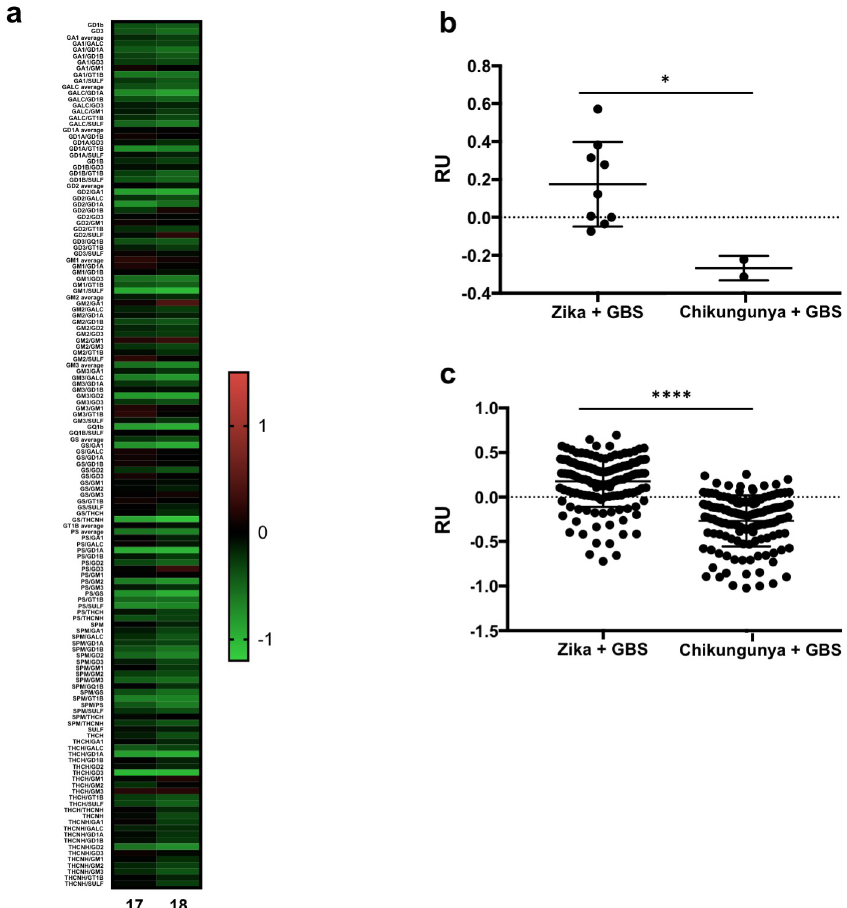
Fig 3. Reactivity of samples from plasma of two GBS patients with active chikungunya virus infection and previous Zika infection (IgG+). ( a ) Heatmap of plasma reactivity to single lipids and lipid combinations. Results from plasma from patients with active chikungunya virus infection (IgM+) and previous Zika infection (IgG+) and GBS compared with Zika infection alone and GBS. ( b ) Average of reactivity values for all lipids and combinations in samples from these patients. ( c ) Average of reactivity values for each lipid and lipid combinations in samples from these patients. Data are expressed as RU values. � p < 0.05, �� p < 0.01, ��� p < 0.001, ���� p < 0.0001, when the groups are compared to each other by unpaired